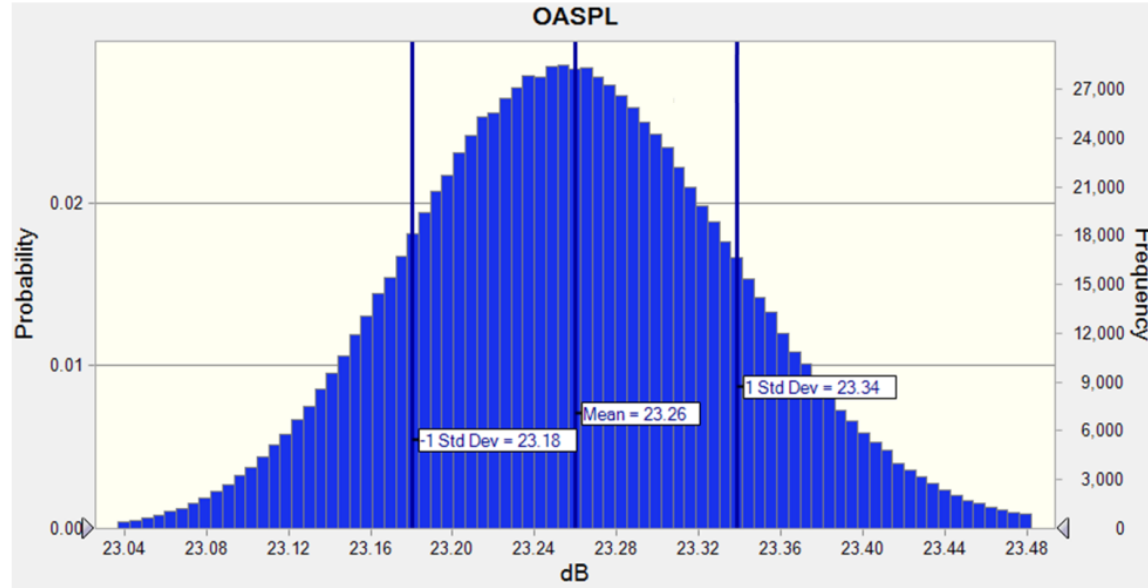
Figure 19. Performance distribution of probability normal distribution for OASPL.